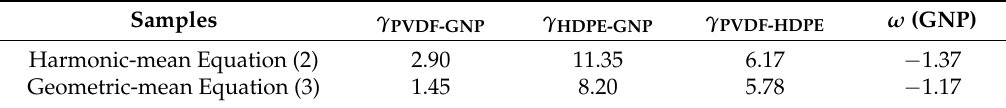
Table 2. Interfacial tension and calculated wetting coefficient of composites at 190 ◦ C.